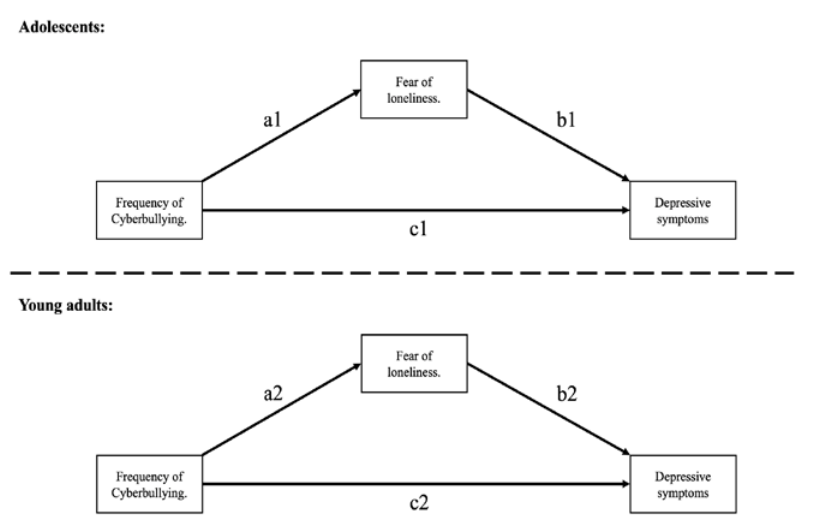
Figure 1. Proposed moderated mediation model.